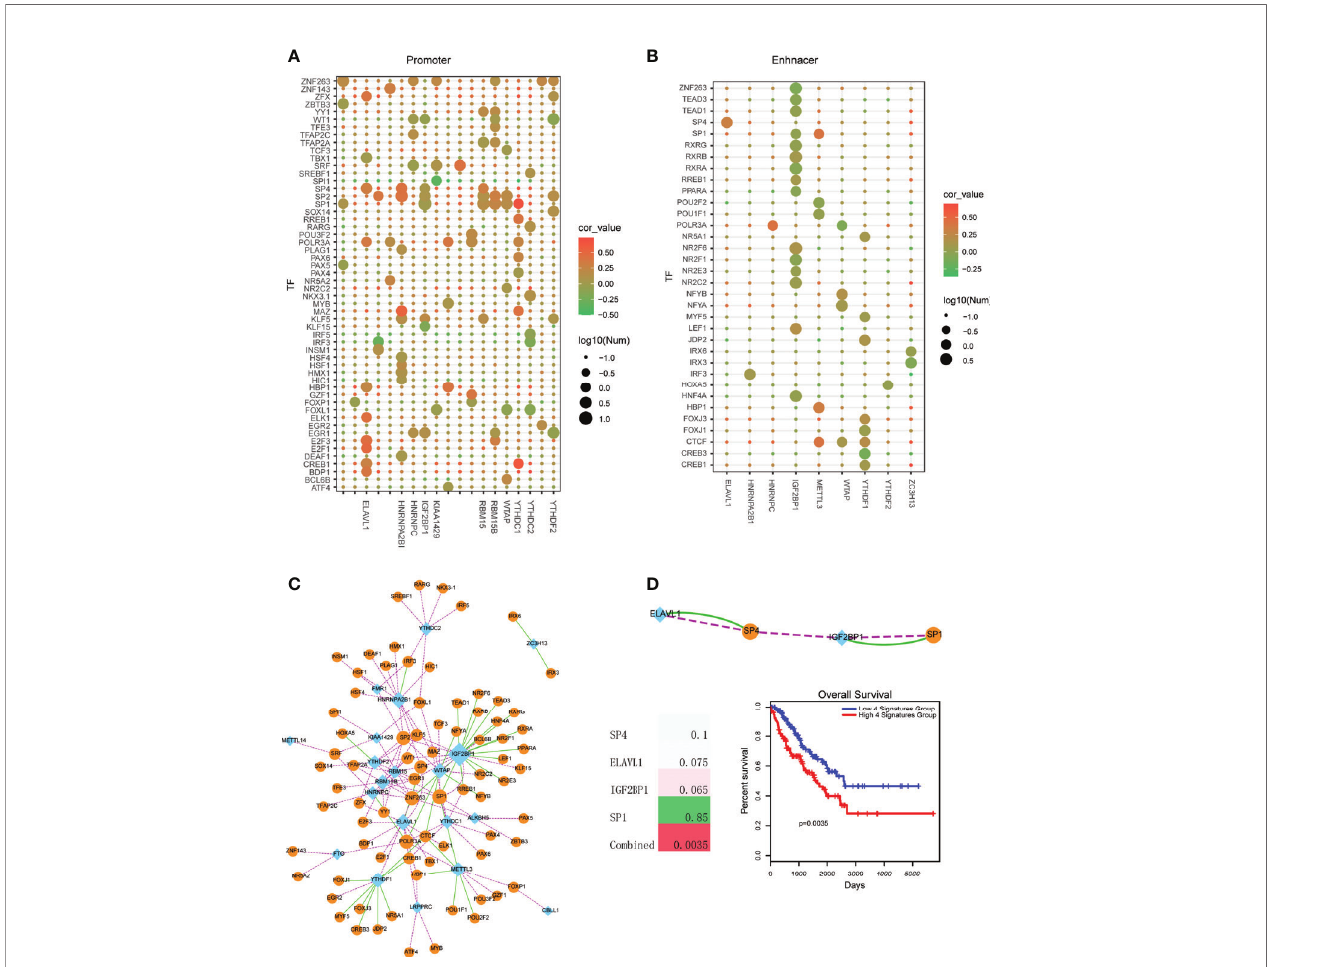
FIGURE 4 | Identi fi cation of TF-m6A regulator crosstalks in sarcoma. (A) TF motif searching of promoter regions of m6A regulators. Node color represents the PCCs between TFs and m6A regulators. Node size represents the number of TFs that bind to the promoter regions of m6A regulators. (B) TF motif searching of enhancer regions of m6A regulators. Node color represents the correlation score of PCC. Node size represents the number of TFs that bind to the enhancer regions of m6A regulators. (C) Visualization of a TF-m6A regulator crosstalk network. Blue diamond nodes represent m6A regulators and orange circular nodes represent TFs. Green lines represent TFs binding to the enhancer regions of m6A regulators. Pink lines represent TFs binding to the promoter regions of m6A regulators. (D) Upper is the TF-m6A regulator crosstalks that were both regulated via enhancer and promoter. Lower left is the survival p-values of individual genes and combined signature in sarcoma. Lower right is the Kaplan-Meier survival curves of combined